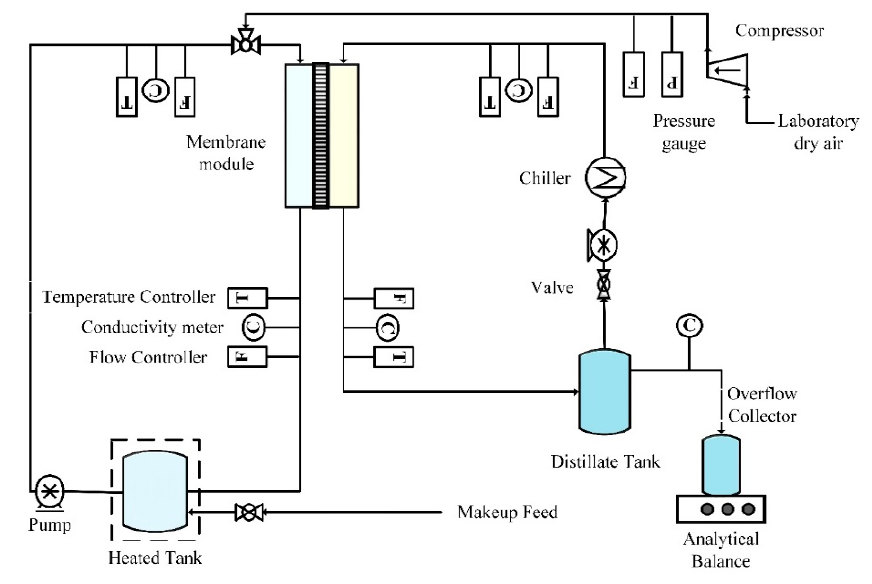
Figure 1. Experimental set up of the AS-MD for HA rejection.